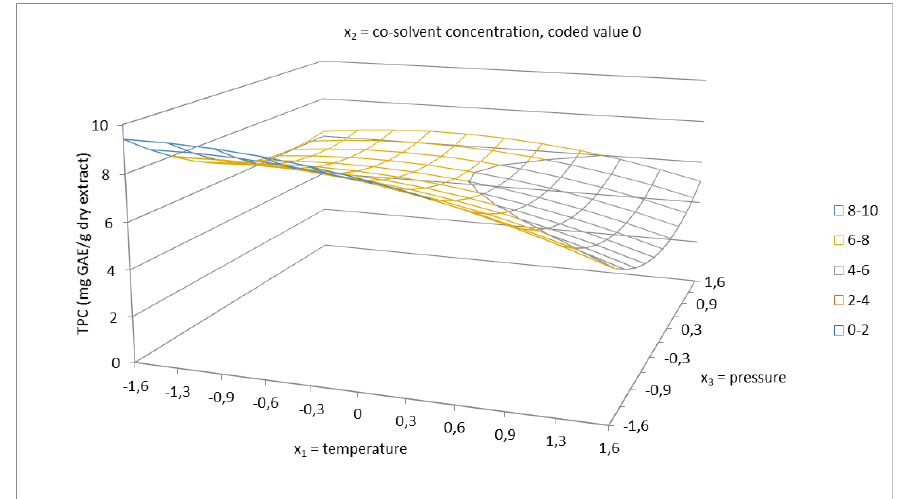
Figure 7. Response surface of total phenolics content as a function of temperature in the range of 40–100 °C and pressure in the range of 1050–9000 psi in coded values at constant EtOH/water cosolvent concentration of 68.3% (coded value 0).